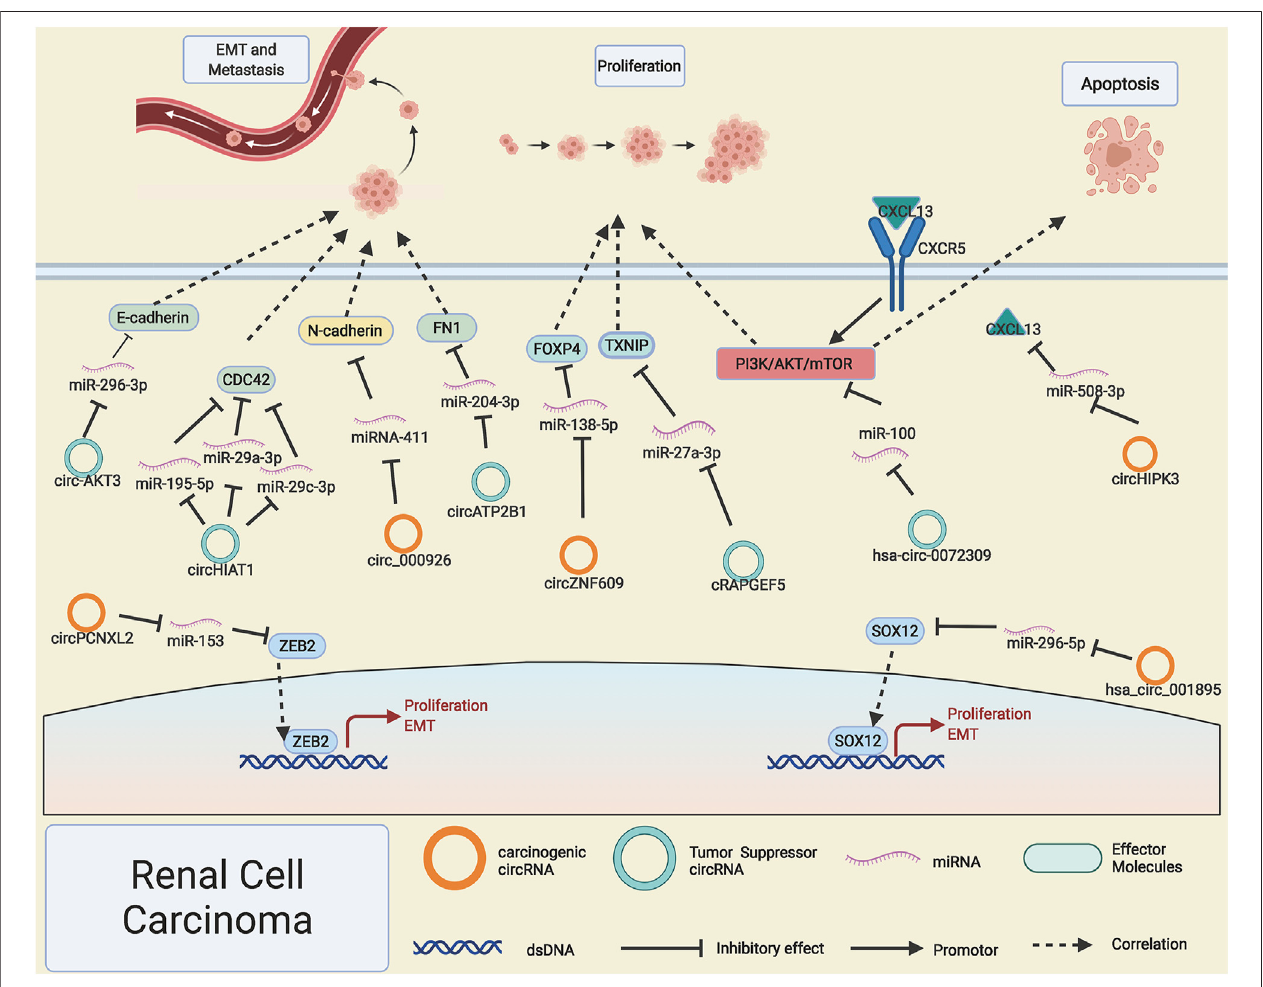
FIGURE 2 | Possible mechanisms of circRNAs in renal cell carcinoma. Upregulated circPCNXL2, circZNF609, hsa_circ_001895, circ_000926, and circHIPK3 (orange rings) and downregulated hsa-circ-0072309, cRAPGEF5, circ-AKT3, circATP2B1, and circHIAT1 (cyan rings) regulate progression of renal cell carcinoma by altering speci fi c gene expression or tumor-related signaling